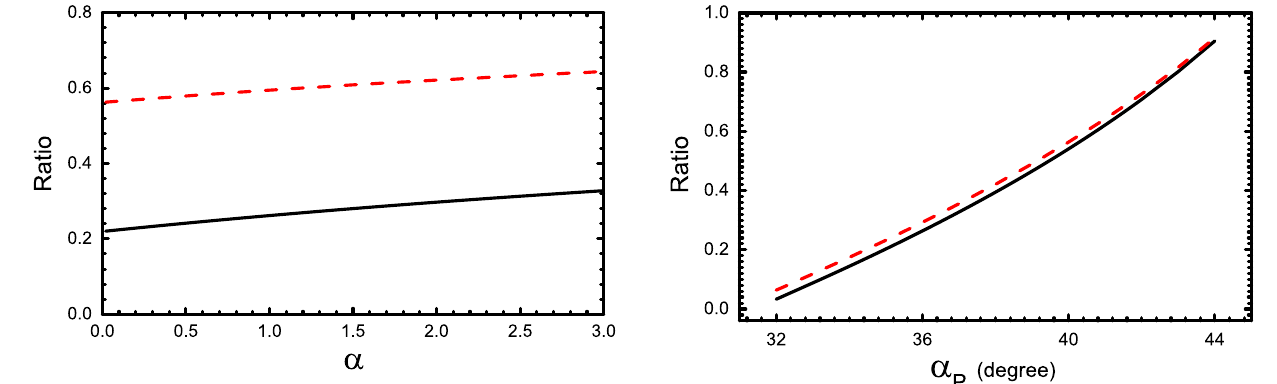
with η – η (cid:3) c Fig. 5 The ratios R h in terms of the η – η (cid:3) mixing angle with α = 0 . 3 c ( solid line ) and α = 1 . 0 ( dashed line